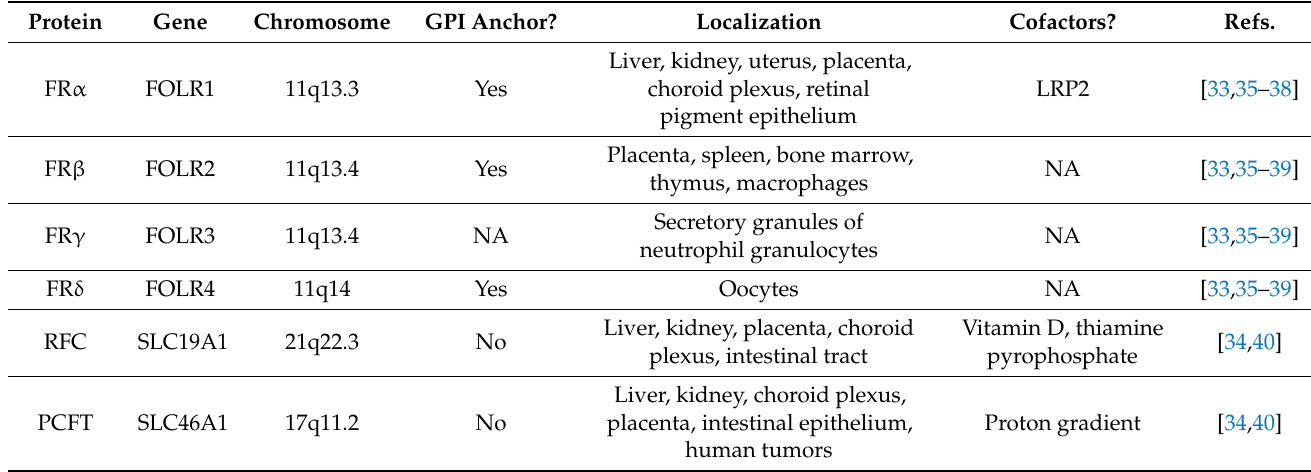
Table 1. Summary of folate